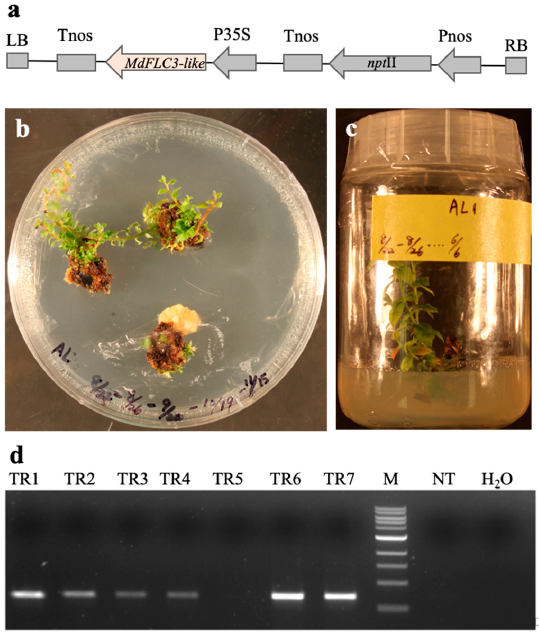
Figure 4. Transformation and ectopic expression of the MdFLC3-like gene in transgenic blueberries. ( a ) T-DNA regions of the construct 35S- MdFLC3-like . LB: T-DNA left border. RB: T-DNA right border. Tnos: nos terminator. Pnos: nos promoter. P35S: cauliflower mosaic promoter. ( b , c ) Selection and regeneration of Km-resistant shoots. ( d ) Genomic PCR detection of 35S-MdFLC in Km-resistant shoots. TR1–TR7: independent transgenic events. M: 1 kb size marker. NT: nontransgenic shoots. H 2 O: water